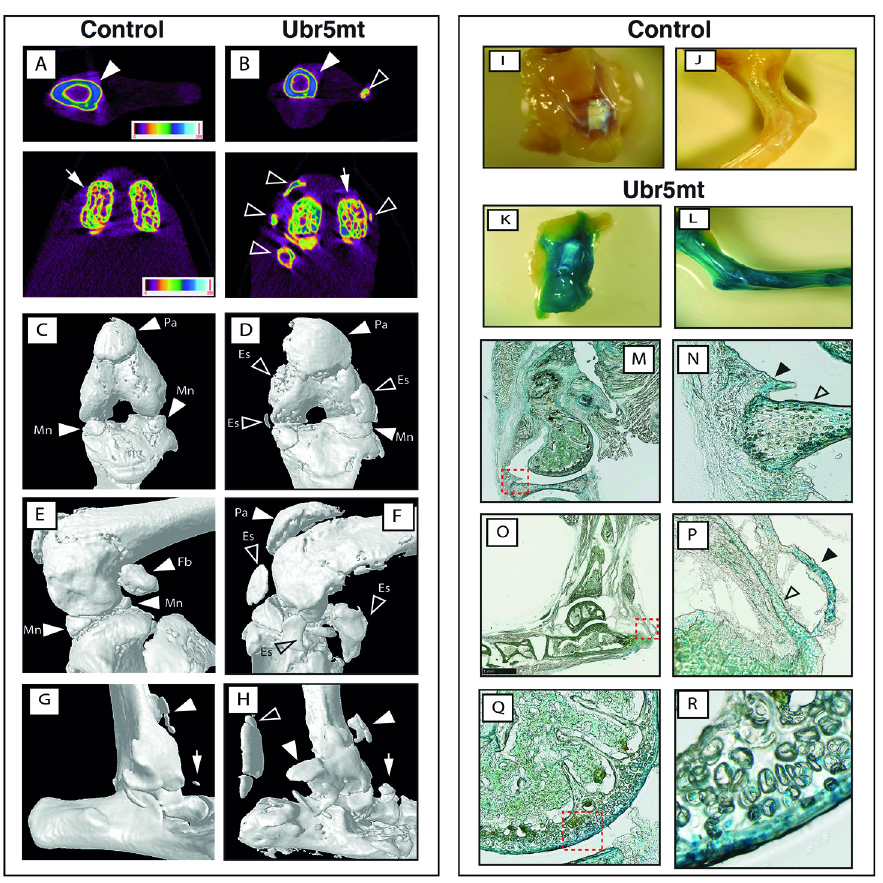
Fig 1. Ubr5 mt animals exhibit multiple ectopic structures around the knee and ankle joints in Ubr5 expressing tissue. 6-month old control and Ubr5 mt animals were analysed by μ CT. (A, B) Color-coded density maps revealed presence of ectopic, non-uniform density structures (open arrowheads) around the tibia (closed arrowheads) and femoral condyles (arrows). (C, D) Knee joints in ventral and (E, F) in medial (lower panels) aspect. Closed arrowheads indicate normal structures: the patella (Pa), menisci (Mn) and fabella (Fb). Open arrowheads indicate ectopic signals (Es) present in the Ubr5 mt knee joint. (G) Control ankle joints exhibit a signal extending from the ventral face of the tibia (closed arrowhead) and a small structure presumed to be a sesamoid bone (arrow). (H) Multiple ectopic signals were present around the Ubr5 mt ankle joint (arrowheads), including a large dorsally located and well-isolated structure in the location of the AT (open arrowhead). (I-R) 20-week-old Prx1-Cre control and Ubr5 mt ankle and knee joints were stained for β -gal activity. Whole mount knee (I, K) and ankle (J, L) are shown with subsequent sagittal sections for the knee (M) and the boxed area magnified in (N) shows the outer layer of the menisci (open arrowhead), and the adjacent synovium (closed arrowhead) stained positive for β -gal expression. Sagittal sections for the ankle are shown in (O) and magnified in (P) showing staining of the AT and superficial digital flexor tendon (open and closed arrowheads, respectively). (Q, R) Expression of β -gal in the articular cartilage of the knee and the red dashed box in Q shown at higher magnification in